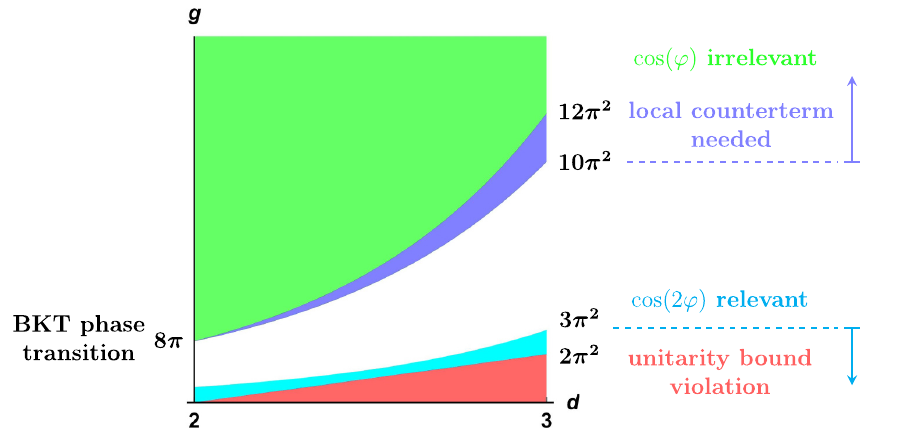
Figure 2 . Phase diagram of generalized sine-Gordon theory with action (6.1) for 2 < d ≤ 3 with the local kinetic deformation tuned to